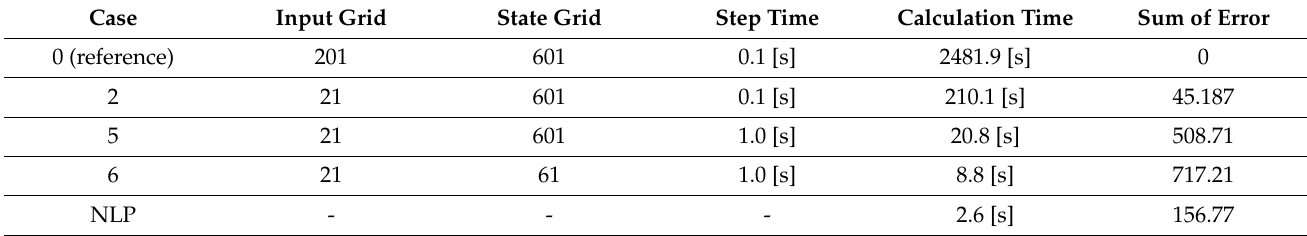
Table 3. Comparison of NLP results and DP results (1): calculation time and sum of error.